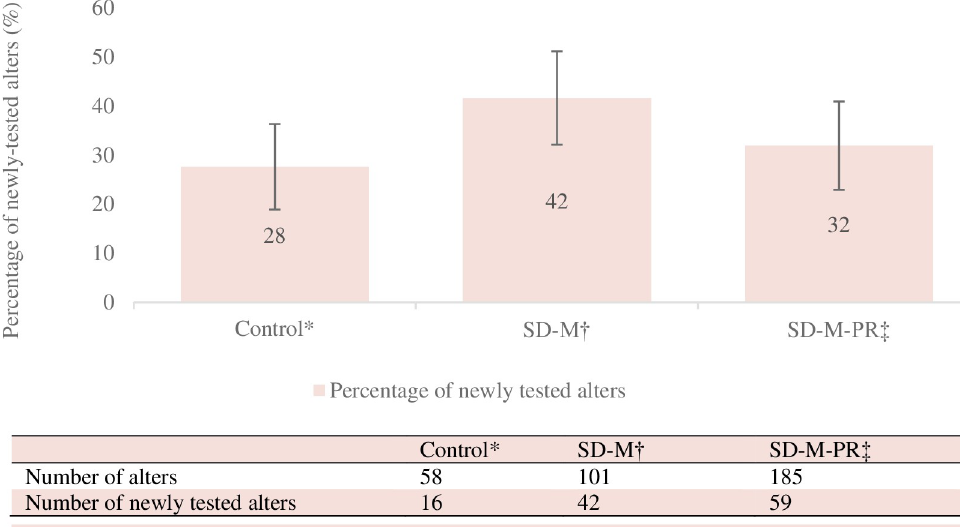
Fig 2. Percentage of newly tested alters among 344 alters at the end of the study, 2019 to 2020. SD-M, secondary distribution with monetary incentives; SD-M-PR, secondary distribution with monetary incentives plus peer referral.